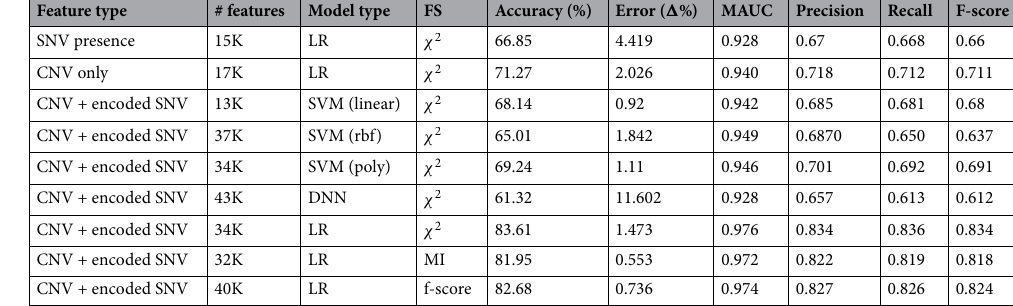
Table 1. Performance of cancer prediction model for each for 11 classes. For each machine learning model and feature selection combination, we report the model with highest performance. The best performing model among them, according to test accuracy, is in boldface. Feature selection denotes the statistical feature selection. Accuracy denoted here is the test accuracy after the last fold and the error measure provides the delta